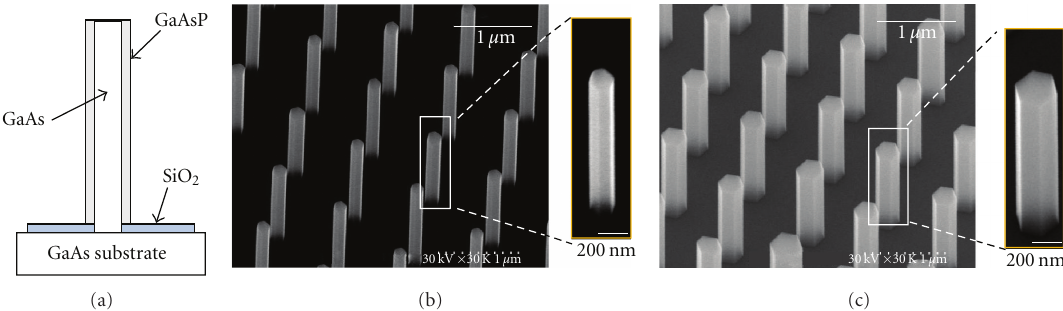
Figure 23: Schematic of structure and SEM images of nanowires. (a) Schematic of cross-sectional structure of core-shell nanowire. (b) and (c) SEM images of as grown GaAs and GaAs/GaAsP nanowires for comparison [32].